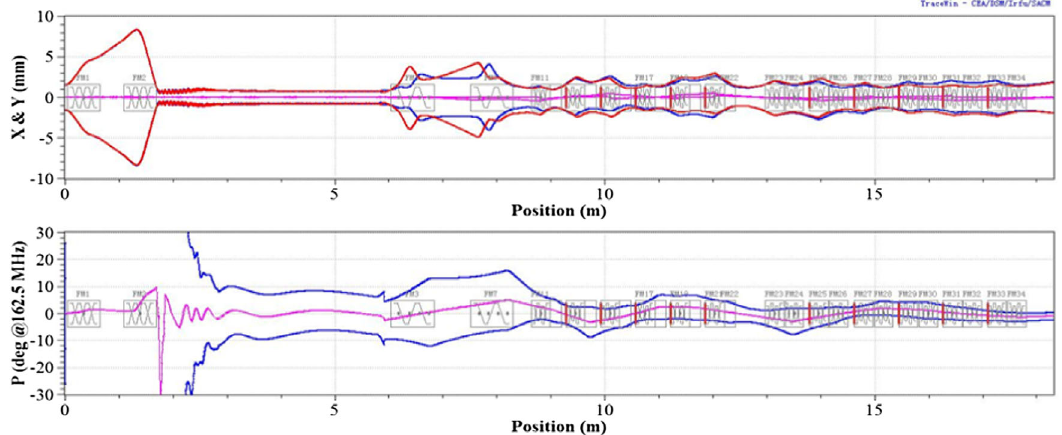
FIG. 3. Beam physics design of the C-ADS injector scheme II.